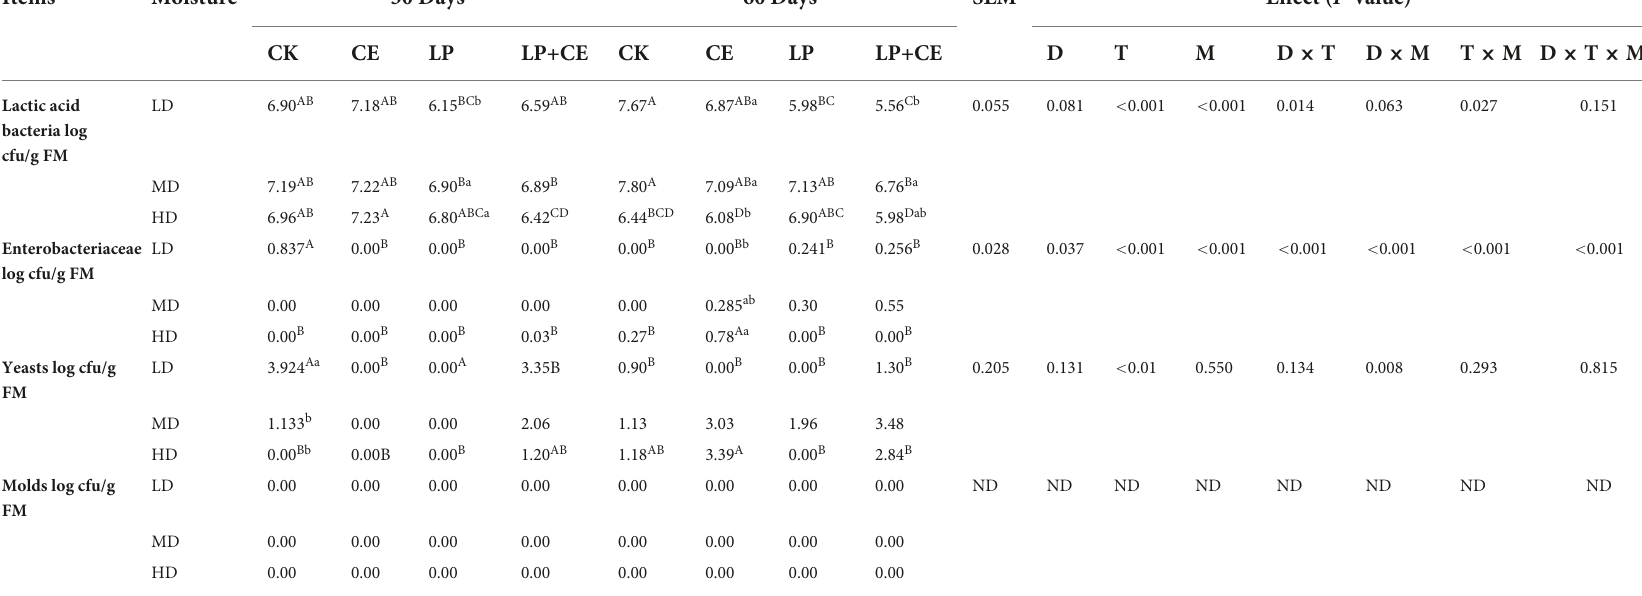
TABLE 3 The microbial counts of oat silage at 30 and 60